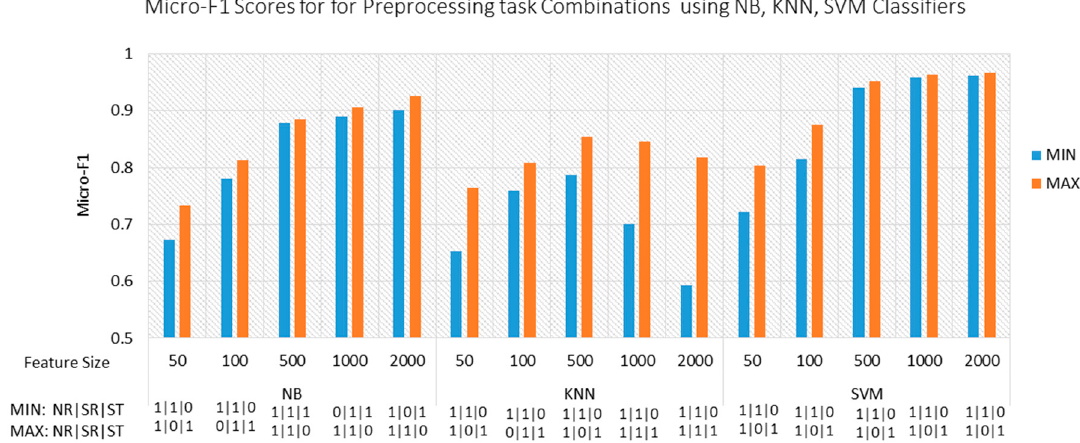
Figure 3. Experimental results and the corresponding combinations of preprocessing tasks for NB, KNN, SVM Classifiers. Table 7. Experimental results and the corresponding combinations of preprocessing tasks.